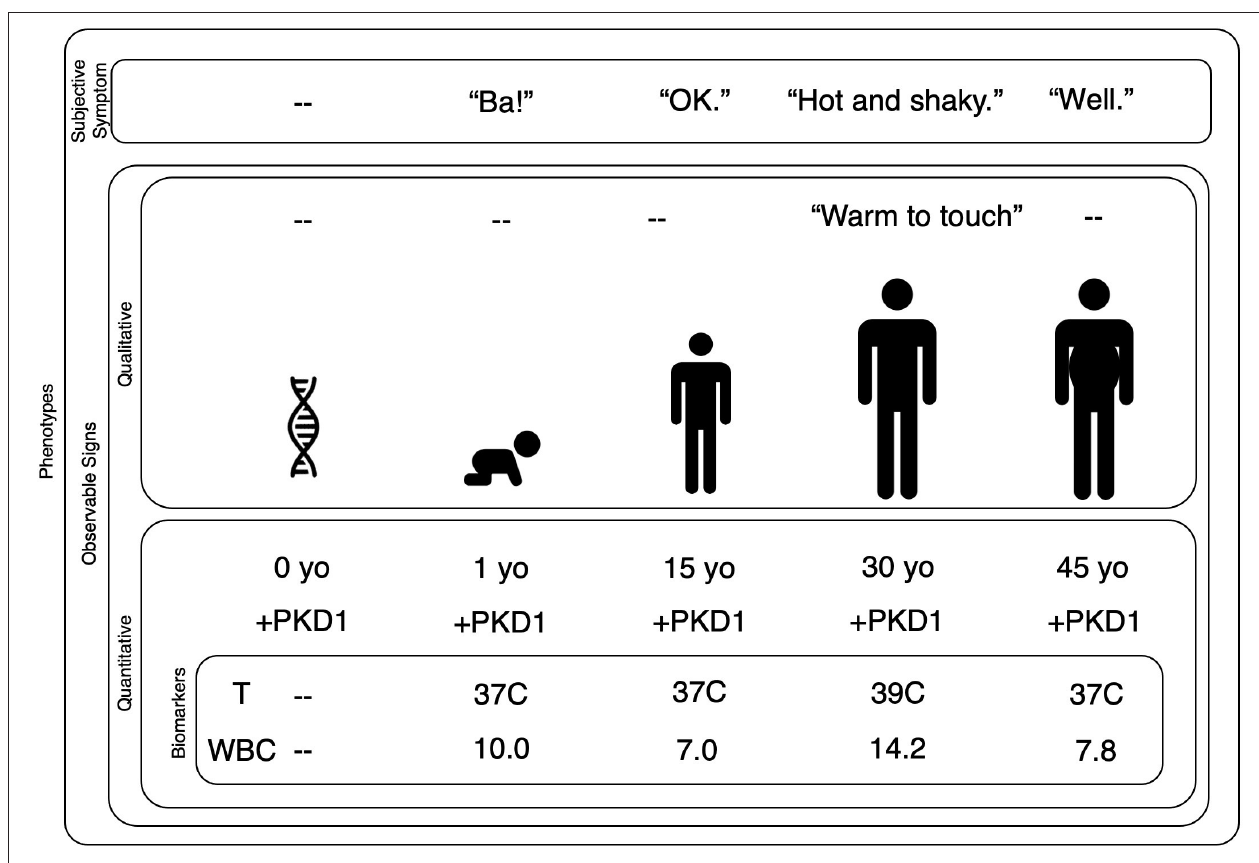
FIGURE 1 | Biomarkers are quantified phenotypes relevant to a decision model. This nested plot shows that subjective symptoms and observable signs are phenotypes. Signs can be observed with qualitative or quantitative methods. A quantitative observable sign requires the use of an instrument to measure the data of interest. A biomarker is a quantitative observable sign that has some bearing on a given decision model. In this case, we are trying to evaluate a 30-year-old man who reports he is “hot and shaky.” A clinician might observe his habitus and record that the man’s skin is “warm to touch.” Quantitative observable signs might include his age and the presence of the PKD1 gene. Our clinical goal is to understand and treat his report of “hot and shaky,” therefore, within our decision model, his age and PKD1 gene status are not necessarily relevant. His temperature and WBC are relevant because they have direct bearing on our decision model. Note that a phenotype can change over time as one’s genes interact with the environment: the symptoms and signs of a bacterial infection are phenotypes that emerge only during the illness. Further note that while some phenotypes may change year-to-year or even moment-by-moment, the autosomal dominant mutation at the PKD1 gene on chromosome 16 will not change. PDK, Polycystic Kidney Disease; yo, year-old; T, temperature; C, Celsius; WBC, White Blood Count (reported as × 10 3 / µ L).